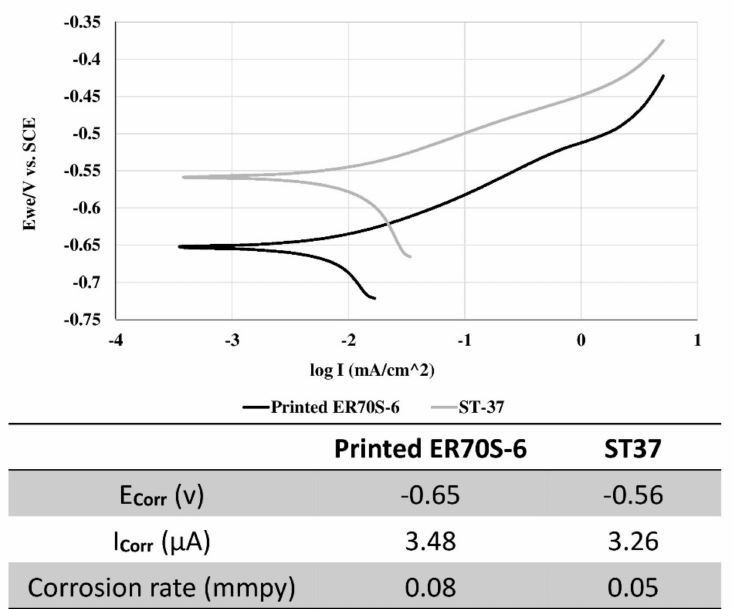
Figure 11. Potentiodynamic polarization analysis of printed ER70S-6 and reference ST37 alloys in 3.5% NaCl